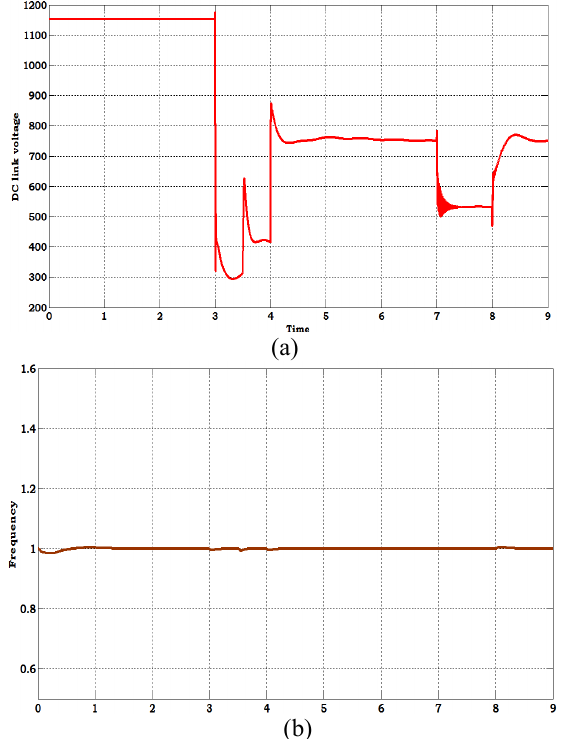
Figure 26. (a). DC link voltage,